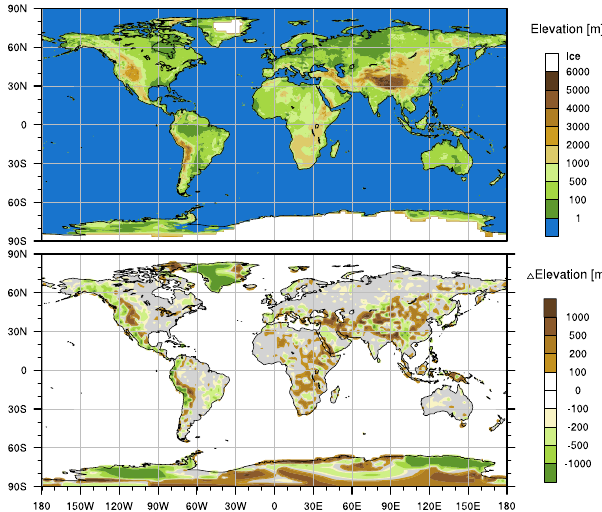
Fig. 1. CCSM4 implementation of PRISM3 land ice distribution and elevation map (top) and elevation anomaly